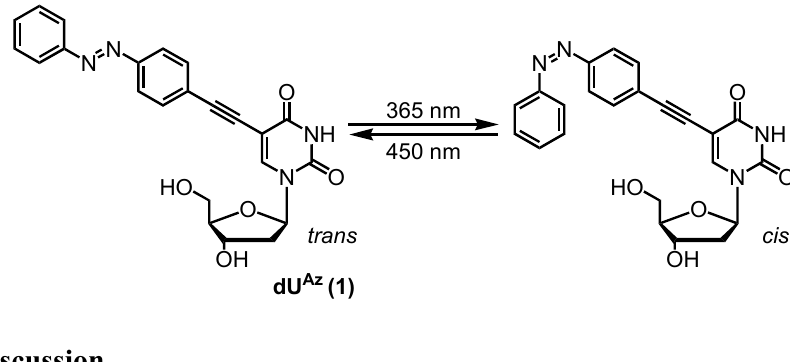
Figure 1. Photoisomeric nucleoside used in this